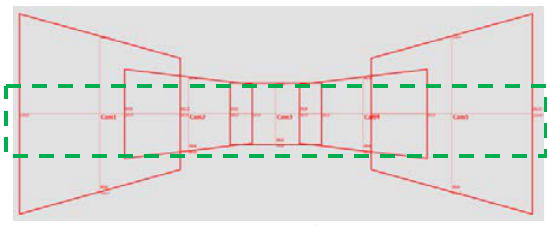
Figure 2. Ground coverage of multi-camera